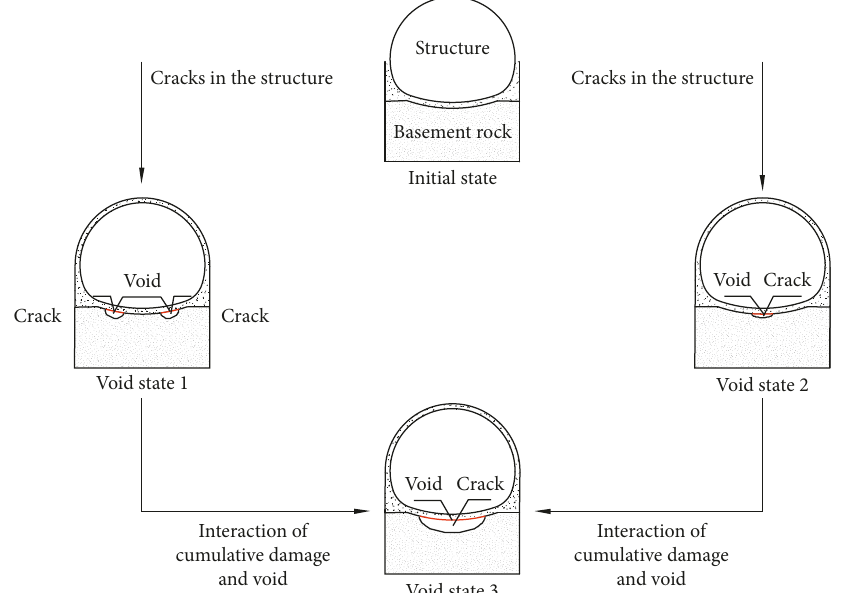
Figure 4: Concept diagram for formation and evolution of base void.